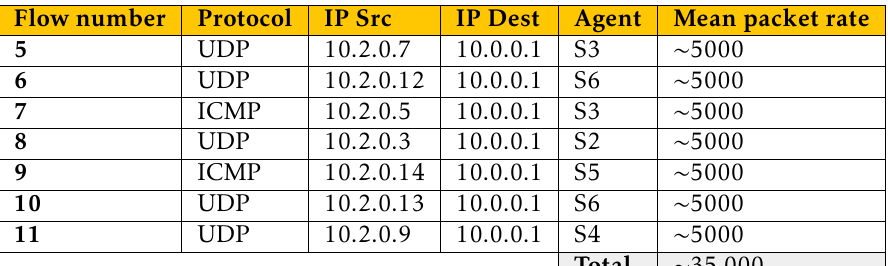
Table 1. Sample Network